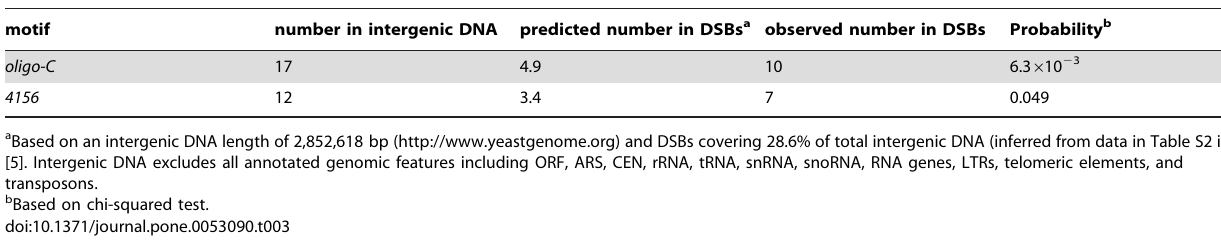
Table 3. Significant association of oligo-C and 4156 motifs with DSBs in intergenic DNA.